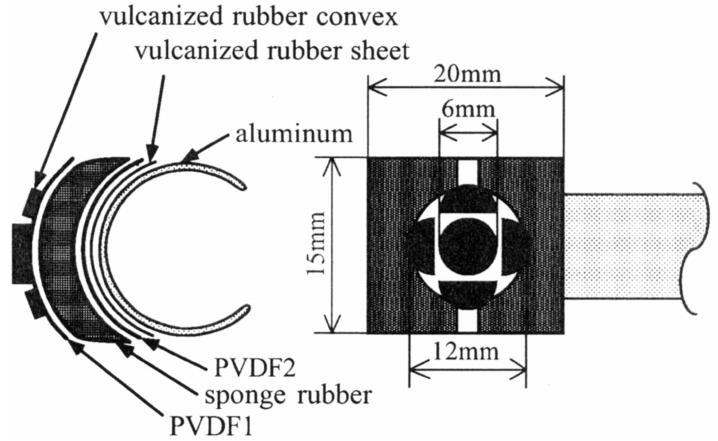
Fig. 14. Cylindrical sensor with Attachment 2 designed for fitting on forefinger. Table 3 Variation of regression coefficients b and correlation co-